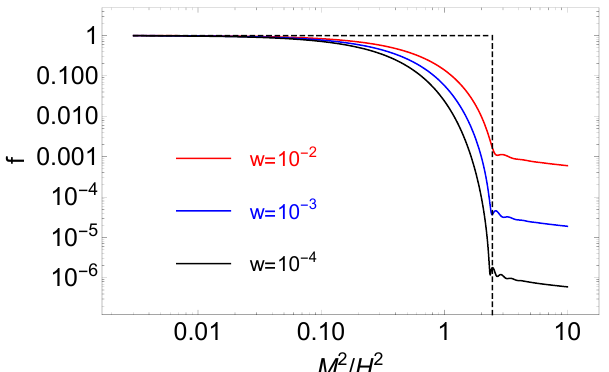
Figure 2. Dependence on M 2 =H 2 of f in eq. (2.23), governing the amplitude of the stochastic noise in (2.16), for di(cid:11)erent values of w . The dashed line represents the zeroth-order description that is often used, with f = 1 for M 2 =H 2 < 9 = 4 and f vanishing for larger